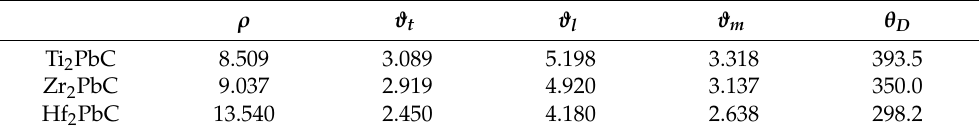
Table 3. Calculated density, ρ , in g/cm 3 , longitudinal, transverse and average sound velocity, ϑ t , ϑ l , ϑ m , in km/s, and Debye temperatures, θ D , in K of Ti 2 PbC, Zr 2 PbC and Hf2PbC. ρ ϑ t ϑ l ϑ m θ D Ti 2 PbC 8.509 3.089 5.198 3.318 393.5 Zr 2 PbC 9.037 2.919 4.920 350.0 Hf 2 PbC 13.540 2.450